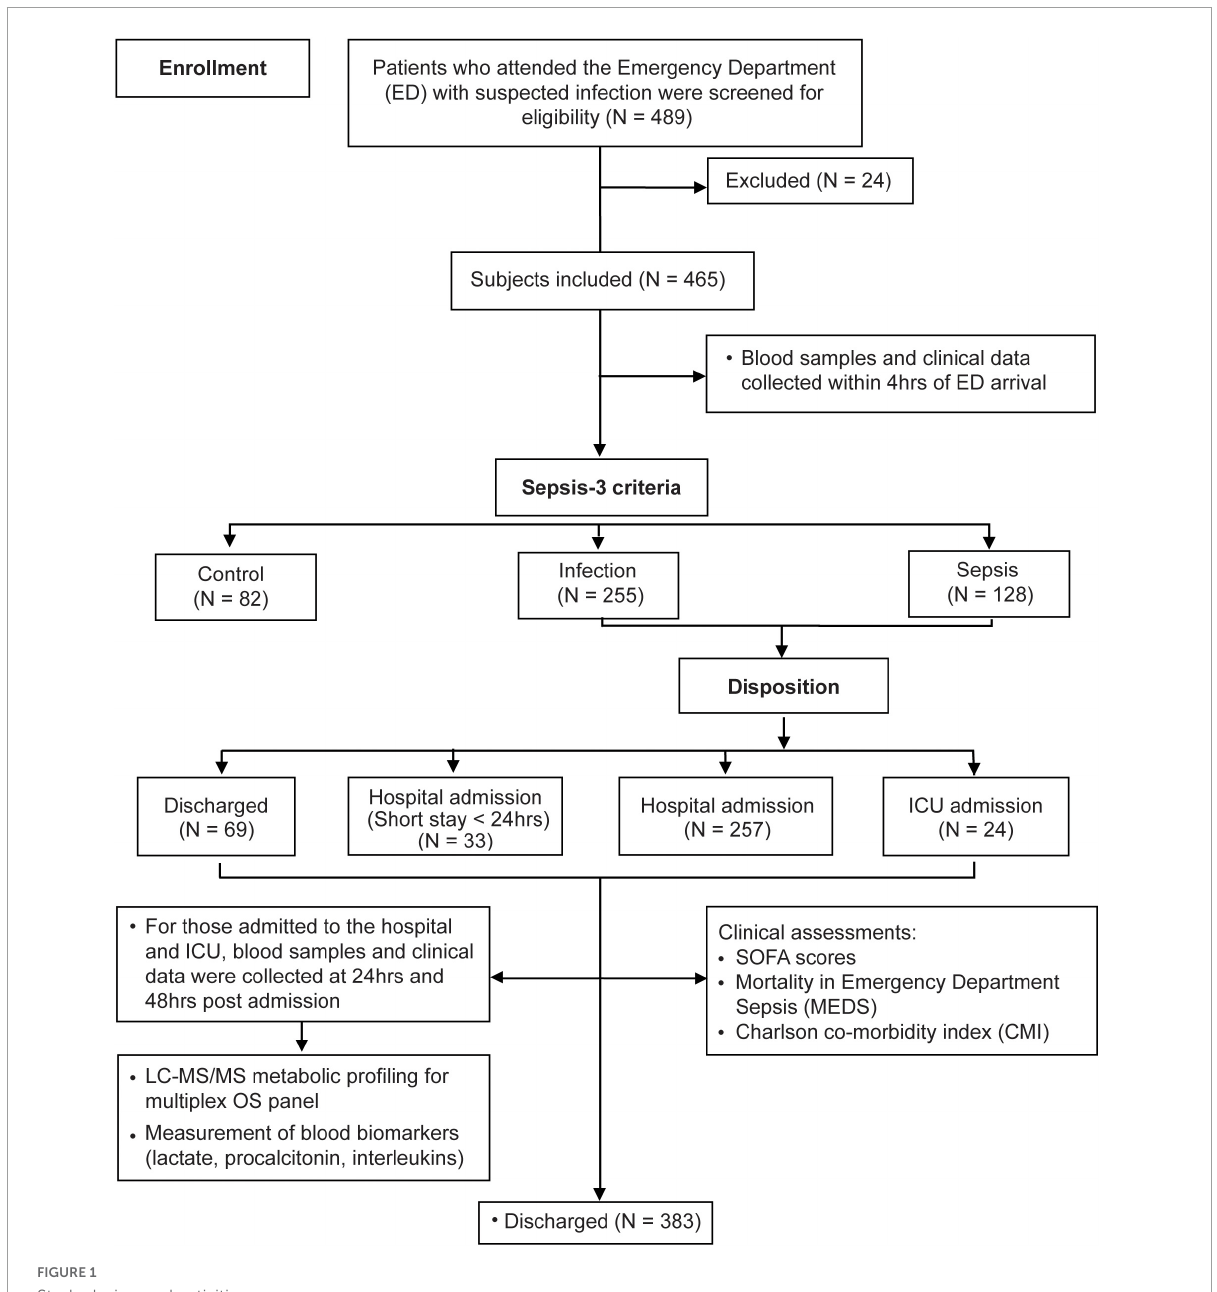
FIGURE1 Study design and